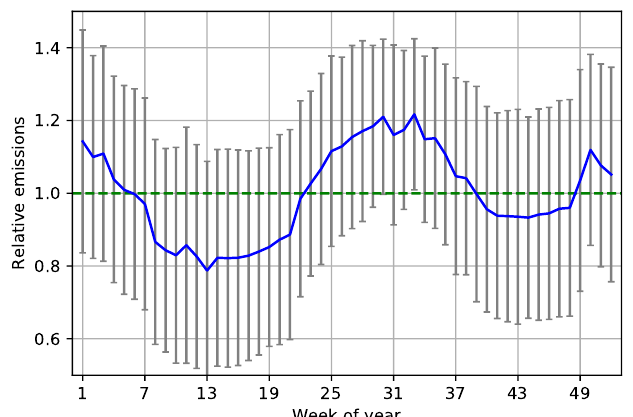
Figure 13. Weekly emission scale factors for 50 highest emitting US power plants, data from 2016–2018. Error bars show the standard deviation in the binned weekly relative